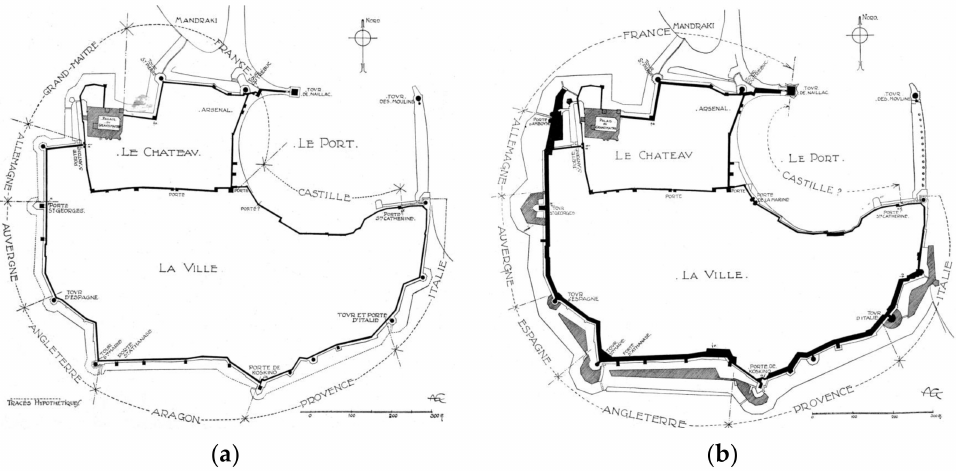
Figure 5. Explanatory map of the medieval City: ( a ) structures and combat posts in 1465 and ( b ) in 1522 Adapted from Ref. [62] 1921, Gabriel